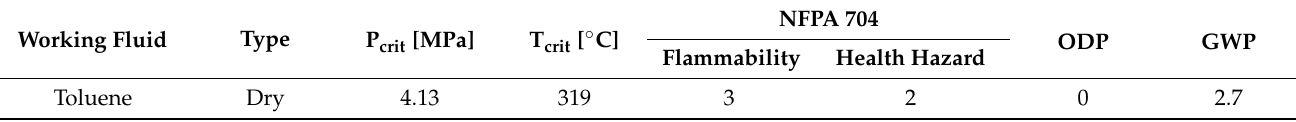
Table 3. Thermophysical properties of the working